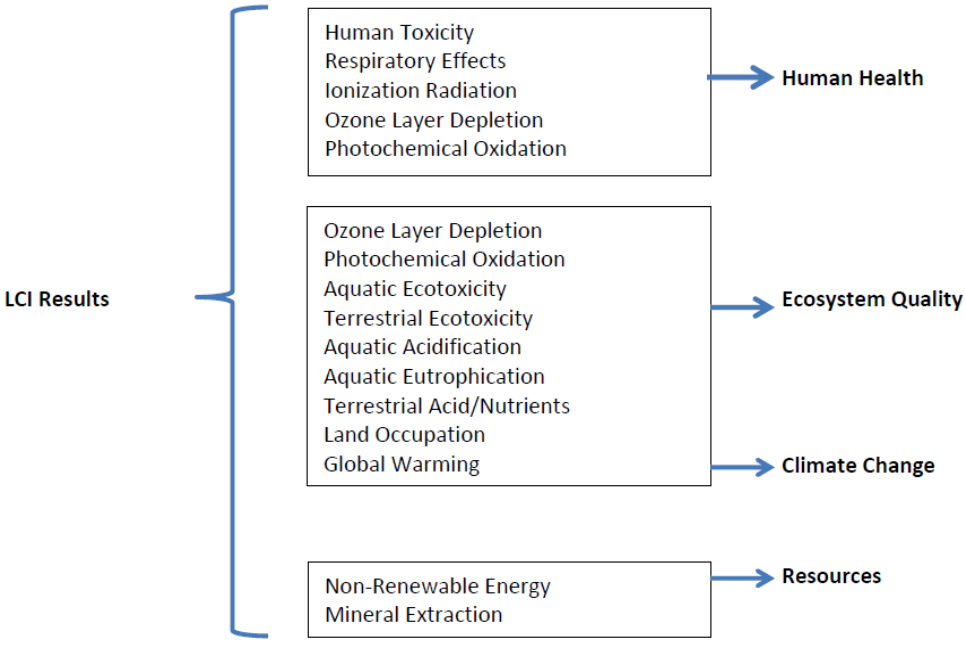
Figure 3. Overall scheme of the IMPACT 2002+ framework [27]. LCI: life cycle